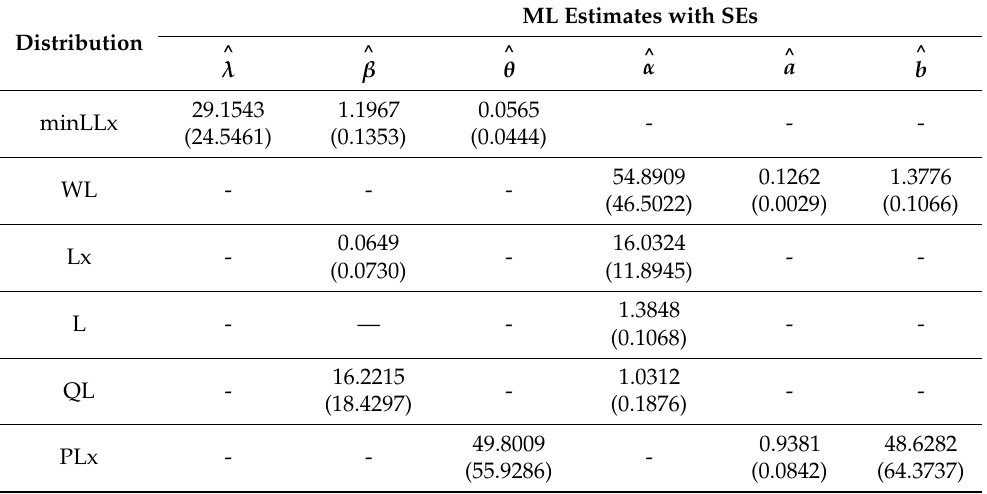
Table 6. The MLEs alongside their accompanying SEs (in parenthesis) for the first data set.